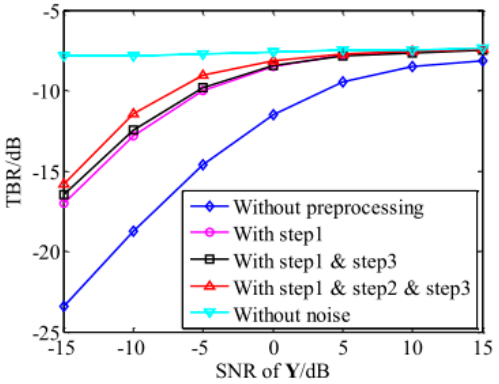
Figure 2. The TBR of the recovered images against the echo SNR.